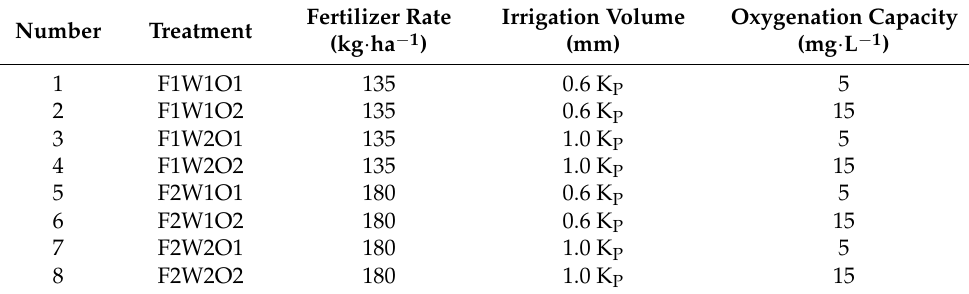
Table 1. Experimental design of water-fertilizer-air-coupling drip irrigation. Fertilizer Number Treatment